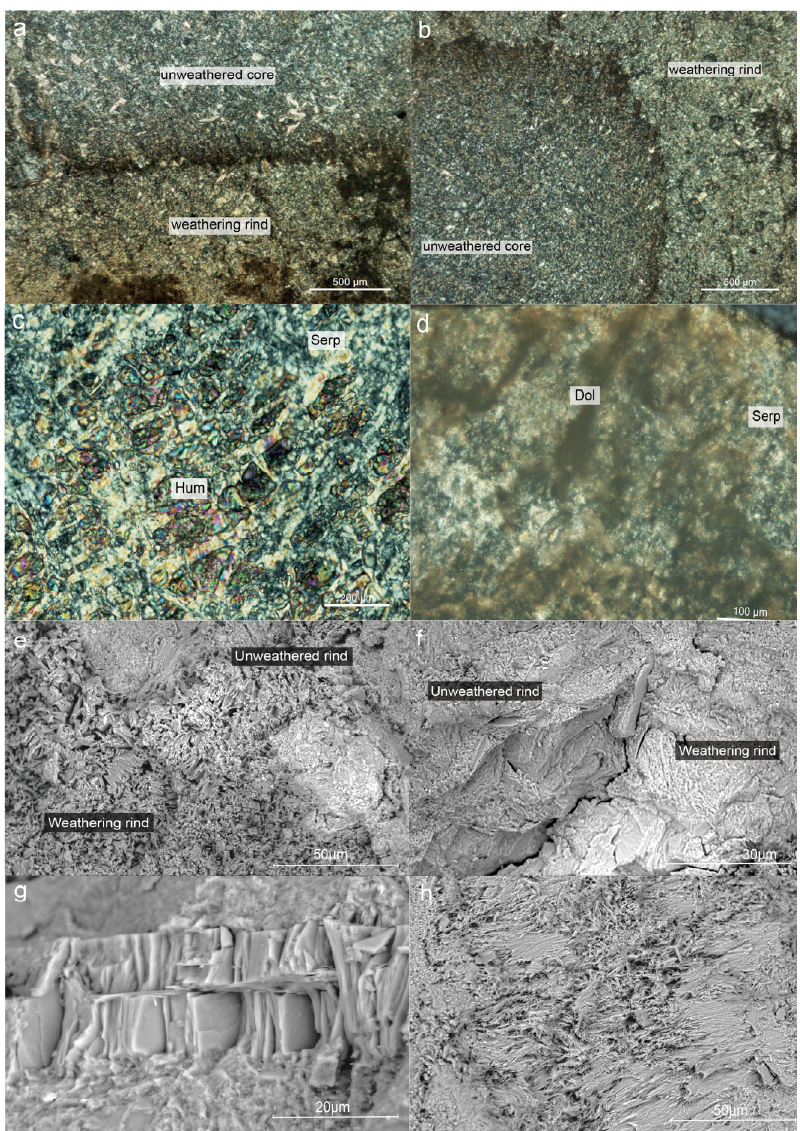
Figure 2. Microstructure characteristics of weathering rinds and unweathered cores observed under CPL and SEM. ( a , b ) The overall feature of weathering rinds and unweathered cores under CPI; ( c ) The replacement remnant structure of unweathered cores; ( d ) Several carbonate veins intrude into the interior of the jade from the weathering rind; ( e , f ) The overall feature of weathering rinds and unweathered cores under SEM; ( g ) The flaky stacking structure of unweathered cores; ( h ) The fibrous interwoven structure of weathering rinds.